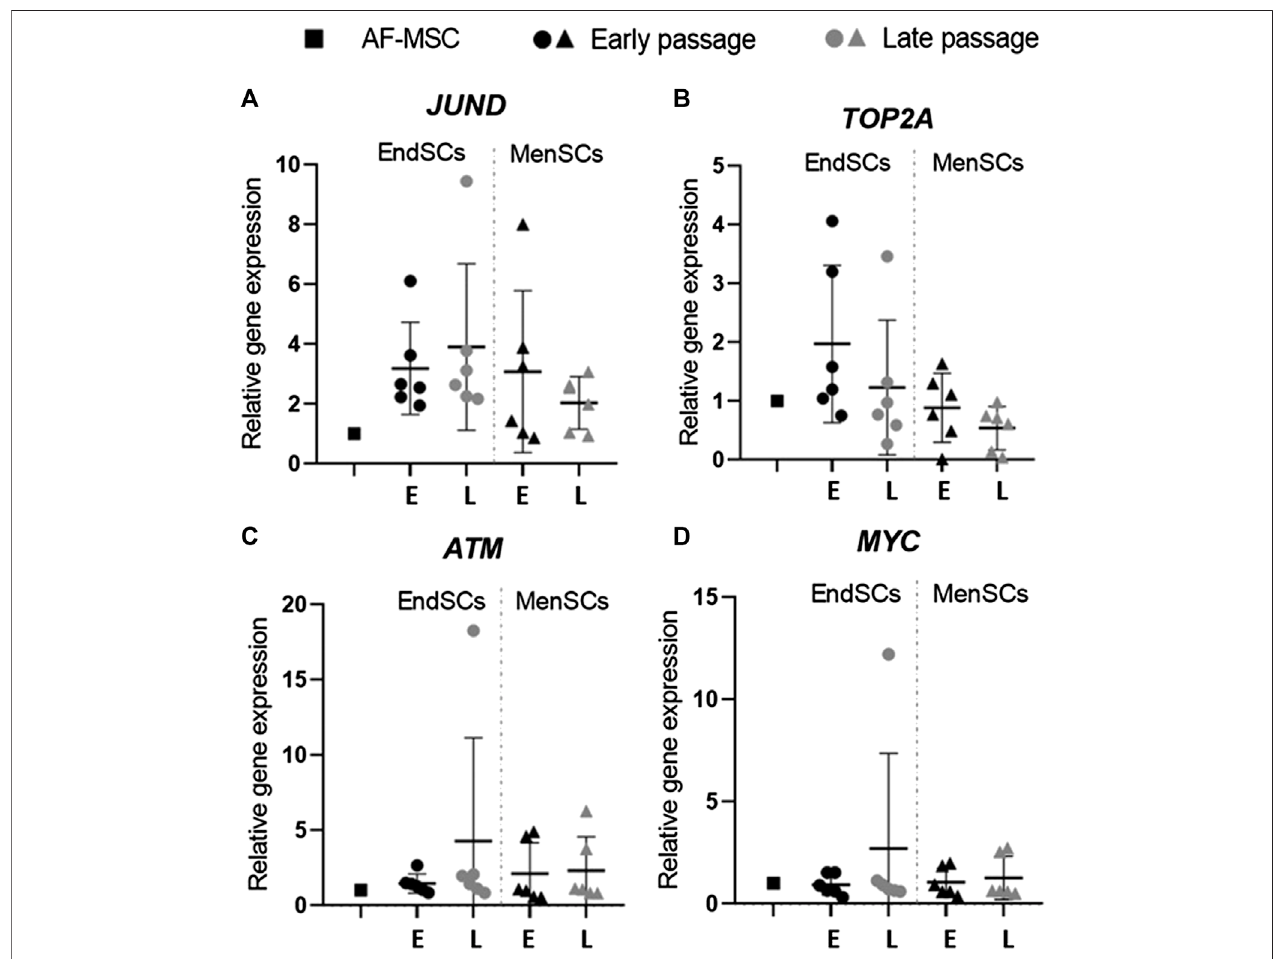
FIGURE 4 | Gene expression analysis of senescence associated genes in EndSCs and MenSCs. (A – D) relative gene expression of JUND, TOP2A, ATM, MYC geneswasdetectedinearlyandlatepassagesandmeasuredusingRT-qPCR.E — earlypassage,L — latepassage.Relativegeneexpressionwascalculatedusing ΔΔ Ct method. Data were normalized to GAPDH and presented as mean ± SD ( n (cid:2) 6). No statistically signi fi cant changes were detected between different passages and cell groups as evaluated by one-way ANOVA.